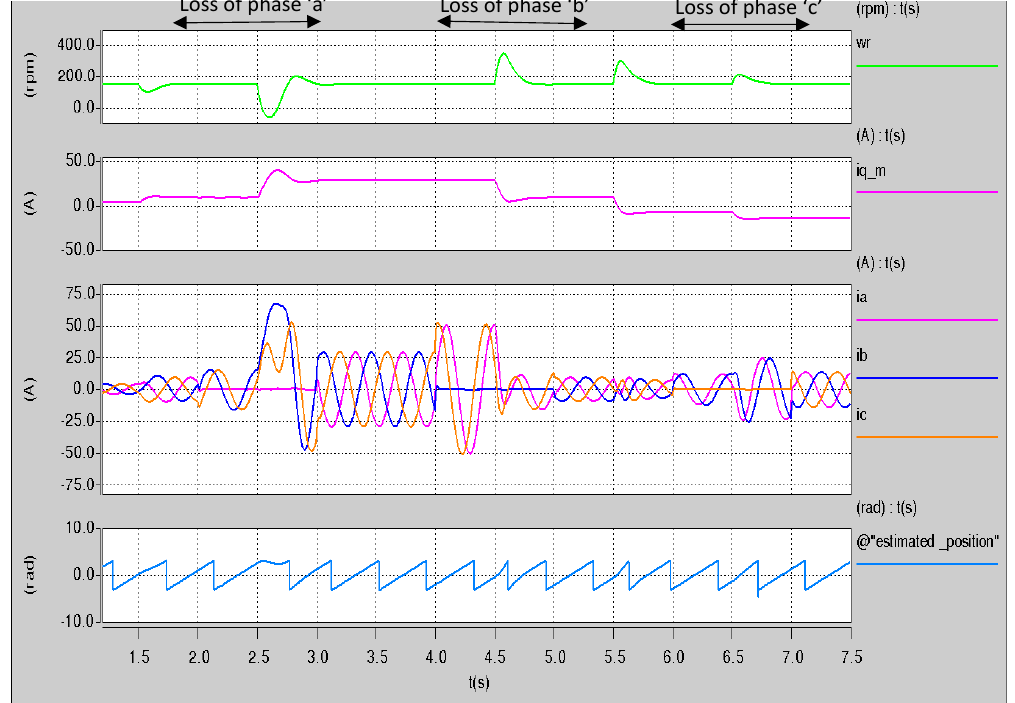
Figure 14. Fully encoderless speed control under different load conditions.